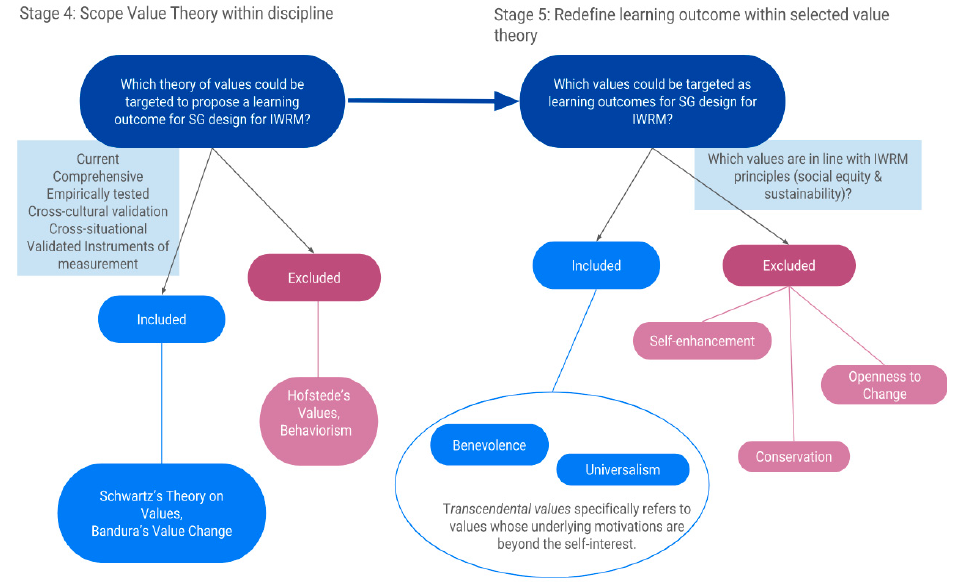
Figure 3. Determining the desired learning outcome for IWRM within the field of social psychology.